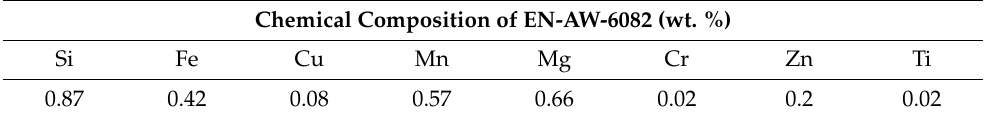
Table 1. Chemical composition of examined aluminum alloy EN-AW-6082.